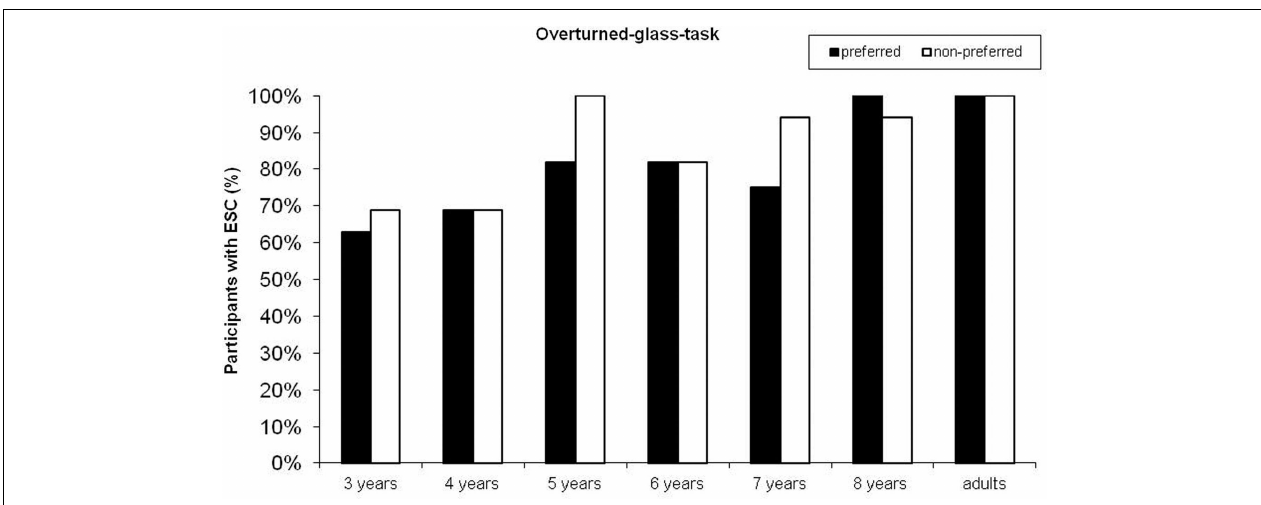
FIGURE 3 | Percentages of participants showing the end-state comfort effect (ESC) in preferred hand and non-preferred-hand-trials across age in the overturned-glass